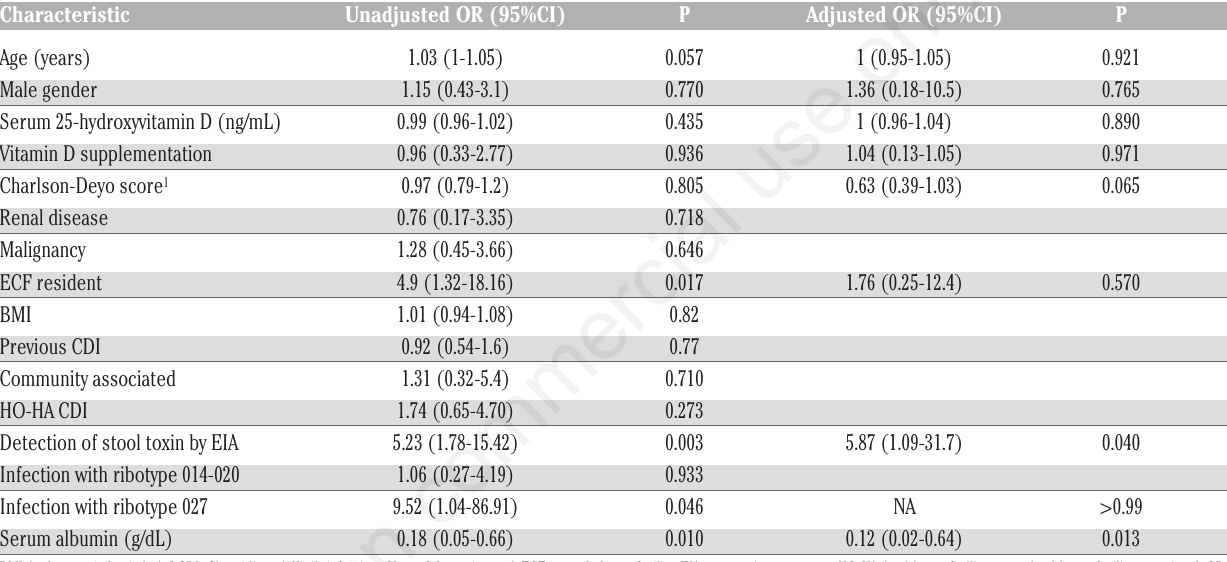
Table 2. Unadjusted and adjusted logistic regression analysis for independent predictors of severe disease. Characteristic